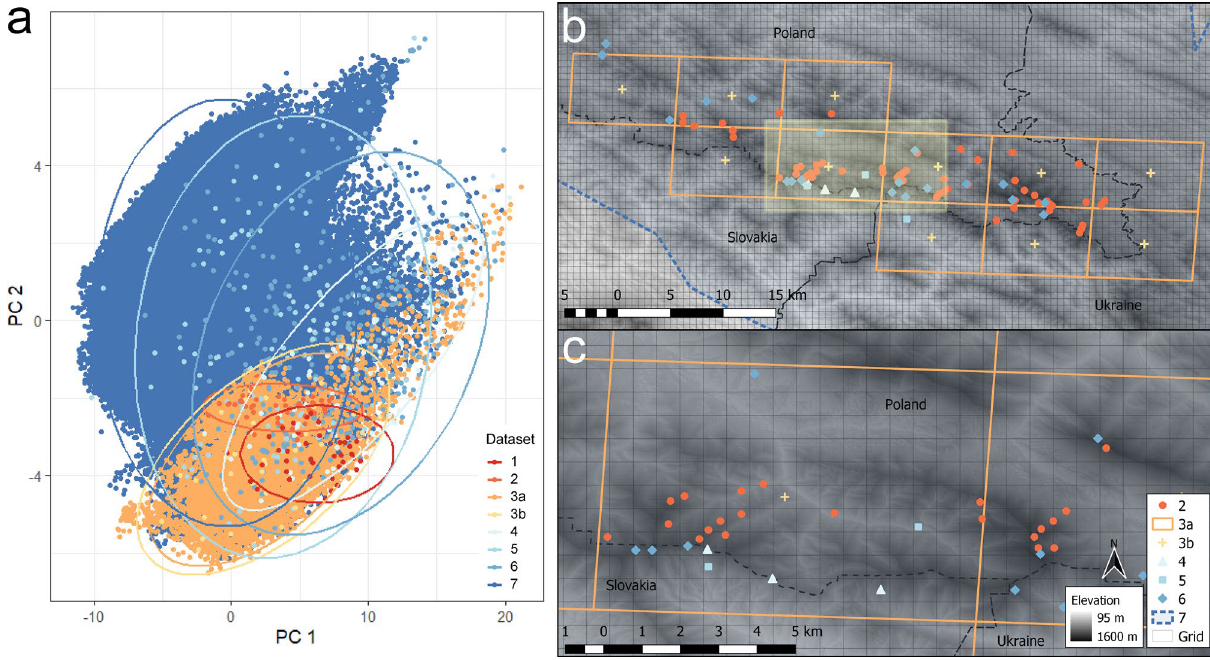
Figure 2. ( a ) Principal Component Analysis (PCA) made using different datasets, ( b ) map of the Bieszczady Mts. (Eastern Carpathians), and ( c ) a portion of the Bieszczady Mts. enlarged to show detailed placement of points. PCA uses as a source specified datasets and illustrates the coverage of environmental variables that corresponds to an environmental space represented by a particular dataset. Circles enclose 95% of the data. Insets ( b ) and ( c ) illustrate varying accuracy of different datasets; the best accuracy is achieved with the regional dataset, with these points aligning well to features of the terrain (2), while the most general dataset, represented by a range (7), falls far outside the recorded occurrences. Numbers correspond to those in Fig. 1: 1—Gorce Mts. 30 , 2—Bieszczady Mts. 31 , 3a—Atpol quadrats 32 , 3b—centroids of Atpol quadrats, 4—Slovakian occurrences 26 , 5—Carpathian occurrences 26 , 6—georeferenced herbarium material, 7—distribution in the Carpathians 33 . Rectangular mesh (Grid) shows the extent of variables in 30 arc seconds. The extent of c is shown by the yellow rectangle on (b). The underlying image in (b) and (c) represents the altitude derived from ALOS DEM dataset 34 with 30 × 30 m